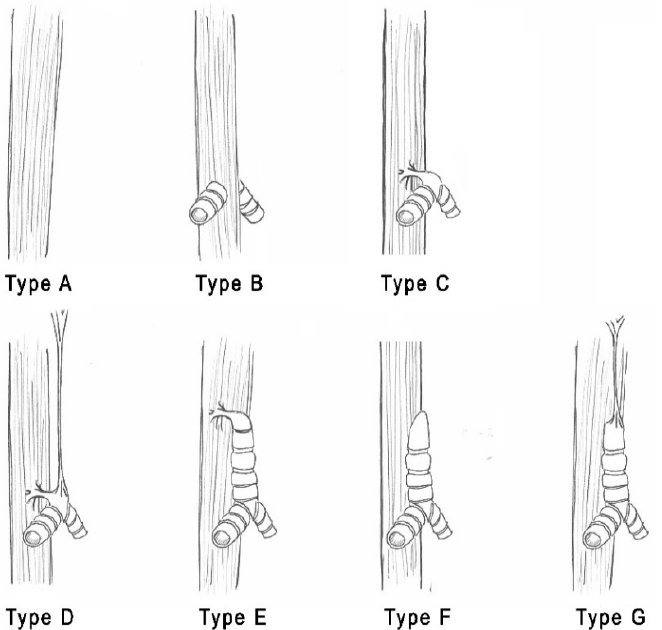
Figure 2. Faro classification: ( Type A ) Tracheopulmonary agenesis; ( Type B ) tracheal agenesis (TA), bronchi attached to the esophagus; ( Type C ) TA, main bronchi connected to the carina with carino-esophageal fistula; ( Type D ) TA with an atretic strand between the trachea and the larynx, carino-esophageal fistula; ( Type E ) proximal TA and distal tracheo-esophageal fistula (TEF); ( Type F ) blind bronchial bifurcation, no esophageal communication; ( Type G ) short segment TA without esophageal